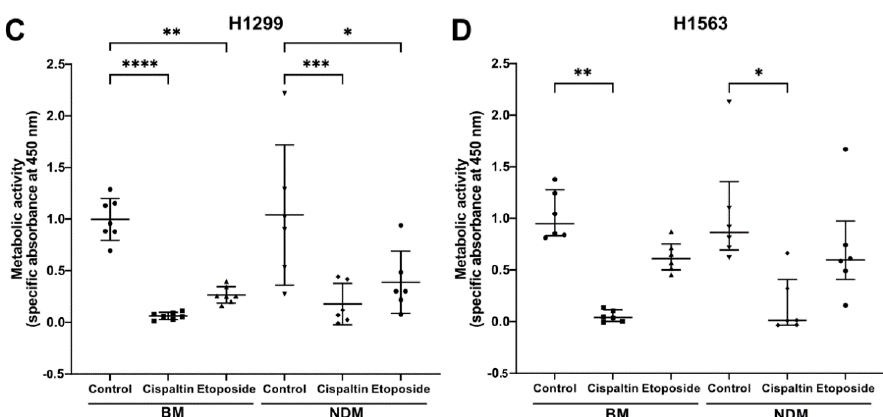
Figure 5. Effects of cisplatin and etoposide on cell viability and metabolic activity in BM and NDM. Cells were cultured for 48 h in BM or NDM in presence or absence of 20 μg /mL cisplatin or 100 µM etoposide. Cell viability analysis by Annexin V 7AAD Apoptosis Detection Kit for H1299 cells ( A ) or H1563 cells ( B ). Livings cells (%) were determined against nontreated controls for each medium separately. p -values of treatment vs. control were calculated with a one-way ANOVA. Data are pre- sented as mean (SD). A p -value below 0.05 was considered as significant. **** p < 0.0001. n = 3 for cell viability (except H1563 BM: n = 5). ( C , D ). Cell metabolic activity assay for H1299 ( C ) and H1563